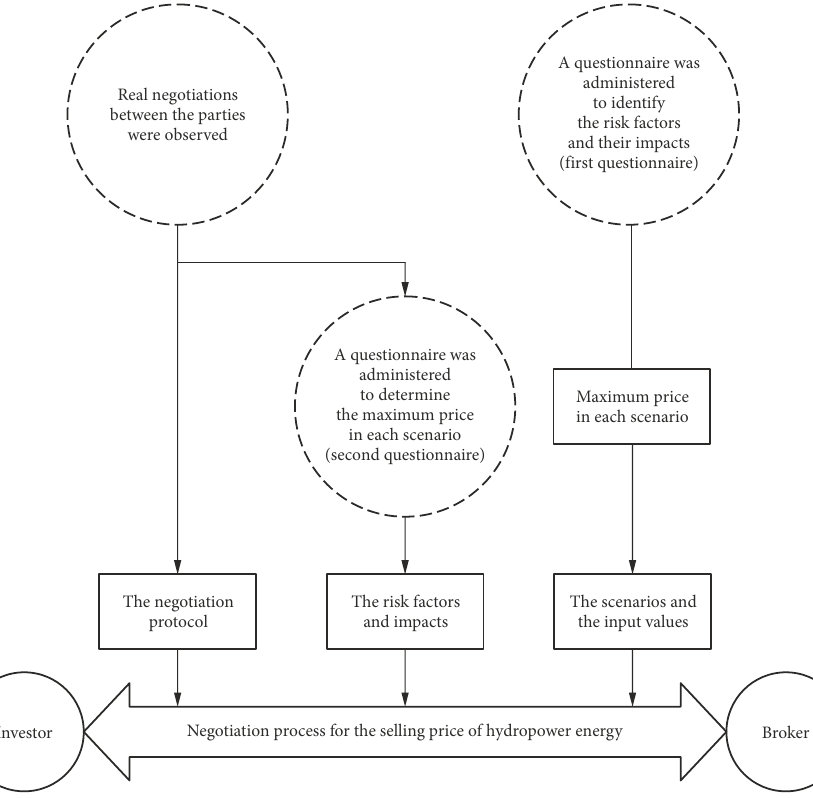
Figure 1. Proposed multi-agent system for the negotiation of the selling price of energy